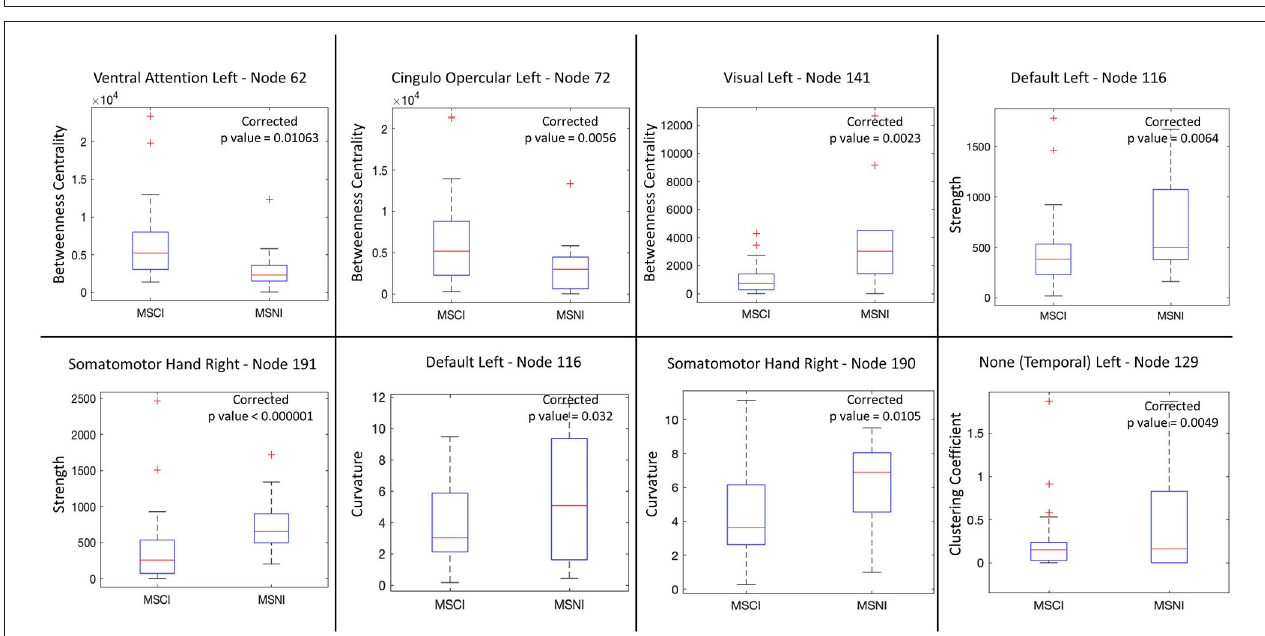
FIGURE 2 | Differences in network (graph) local measures between MS cognitively impaired (MSCI) and non-impaired (MSNI) patients. Betweenness centrality is increased in nodes from the ventral attention and cingulo-opercular networks in MSCI patients. For the other nodes, MSCI show decrease in all measures.